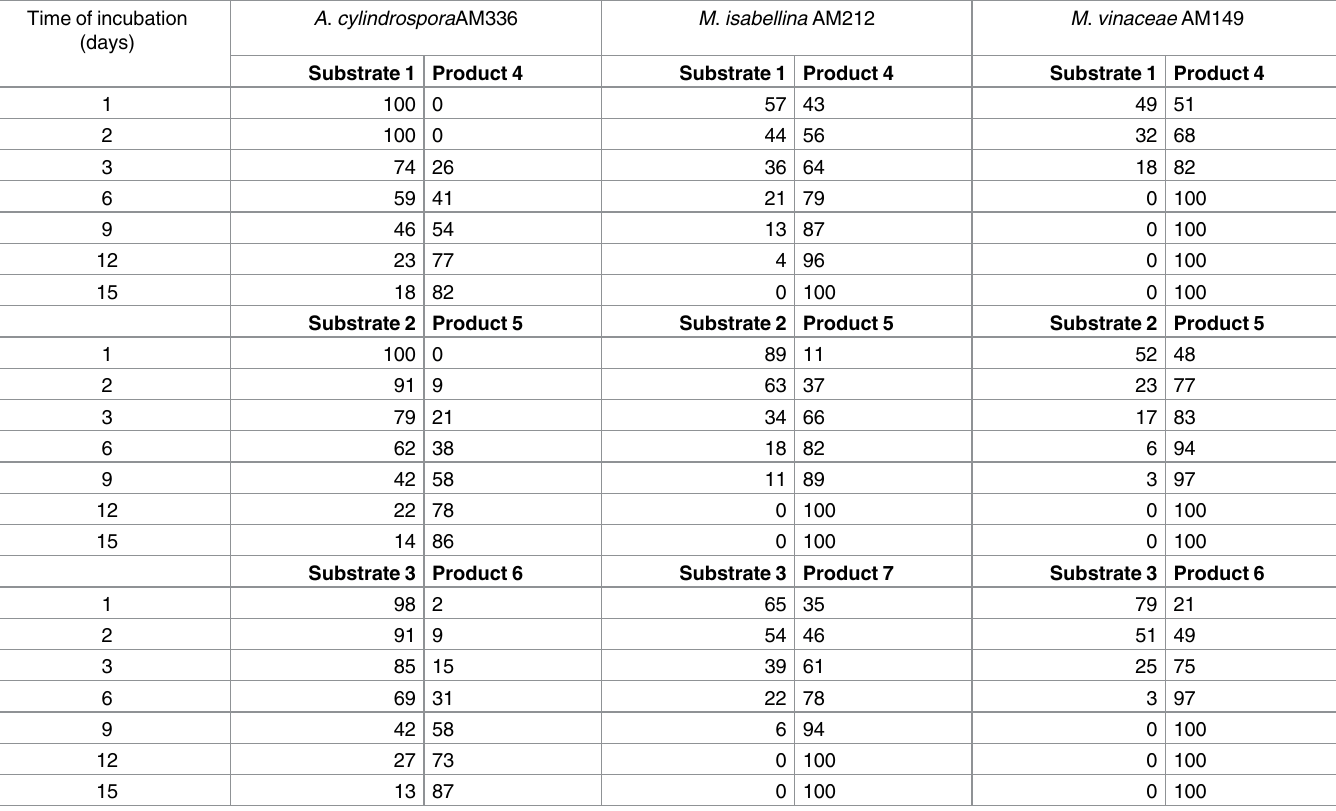
Table 1. The composition (in % according to GC) of the products mixtures in the screening biotransformations of halolactones 1, 2 and 3. Time of incubation